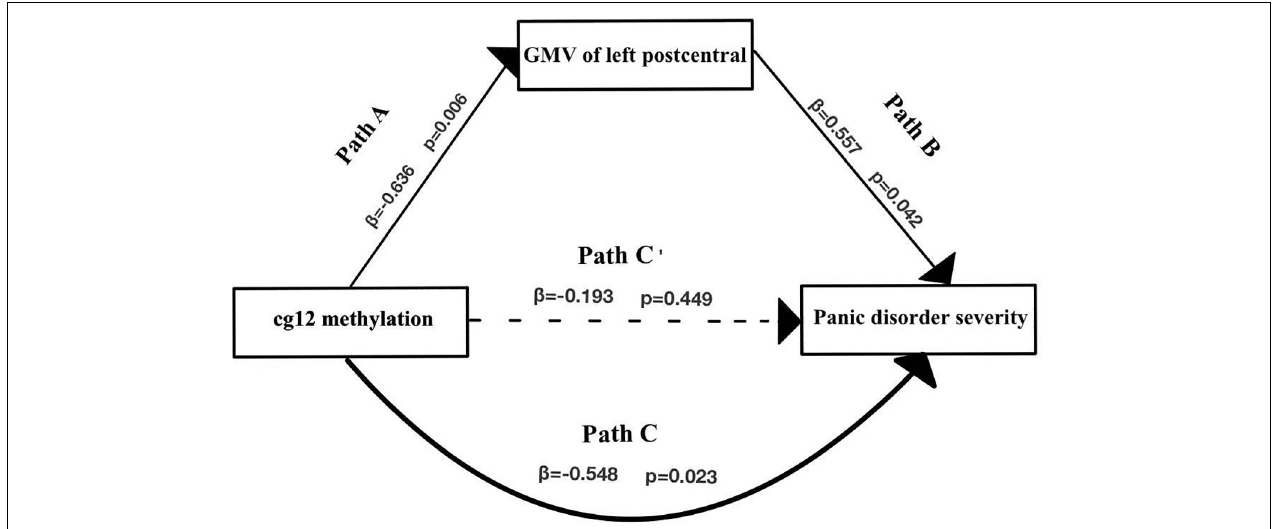
FIGURE 5 | Mediation effect model with three variables in the model. Mediation analysis suggested that cg12/171674146 CpG methylation mediated the relationship between GMV in the left PoCG and PD severity. Indirect effect of cg171674146 on PDSSSUM = 95% CI: –0.873 to –0.068. Direct effect of cg171674146 on PDSSSUM (Path C (cid:48) ) = 95% CI: –0.619 to 0.298. Total effect of cg171674146 on PDSSSUM (Path C) = 95% CI: –0.813 to –0.157.